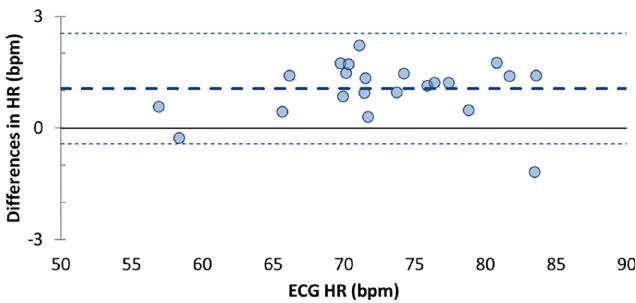
Fig 3. Bland-Altman plots for nocturnal Heart Rate (HR). The thick dotted lines represent the Bland-Altman bias; the thin dotted lines represent the Bland-Altman upper and lower agreement limits.